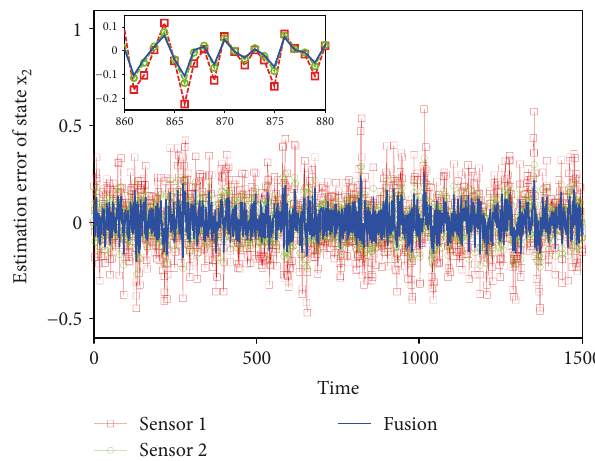
Figure 10: The estimation of x ( L =50).